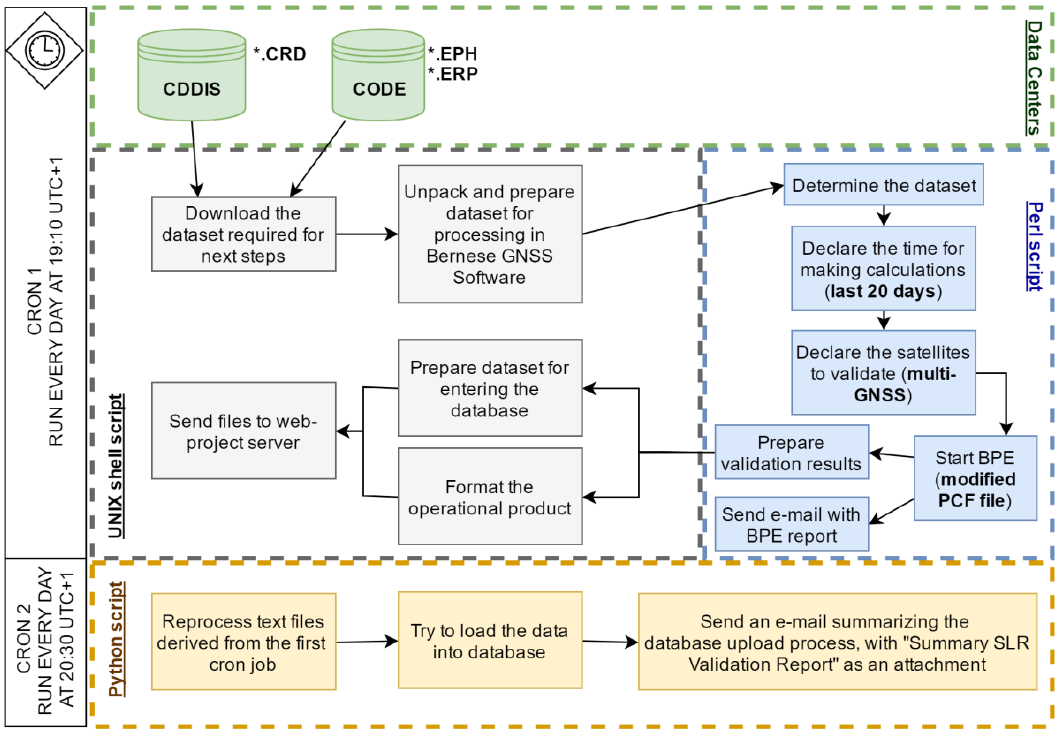
Figure 2. Flow scheme for processing of GOVUS daily campaign. Abbreviations used: CDDIS, Crustal Dynamics Data Information System; PCF, Processing Control File; BPE, Bernese Processing Engine.